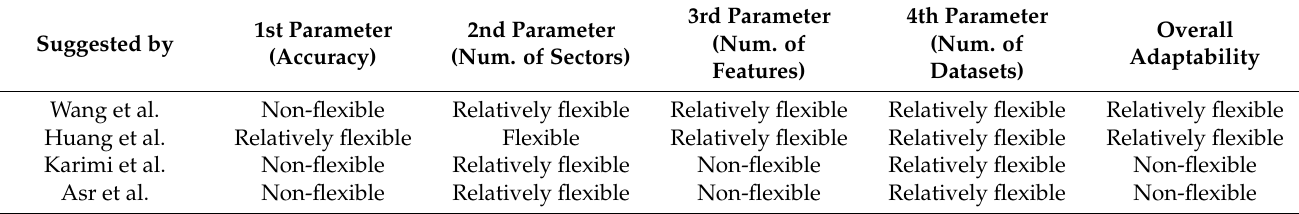
Table 14. Adaptability of Cross-Source